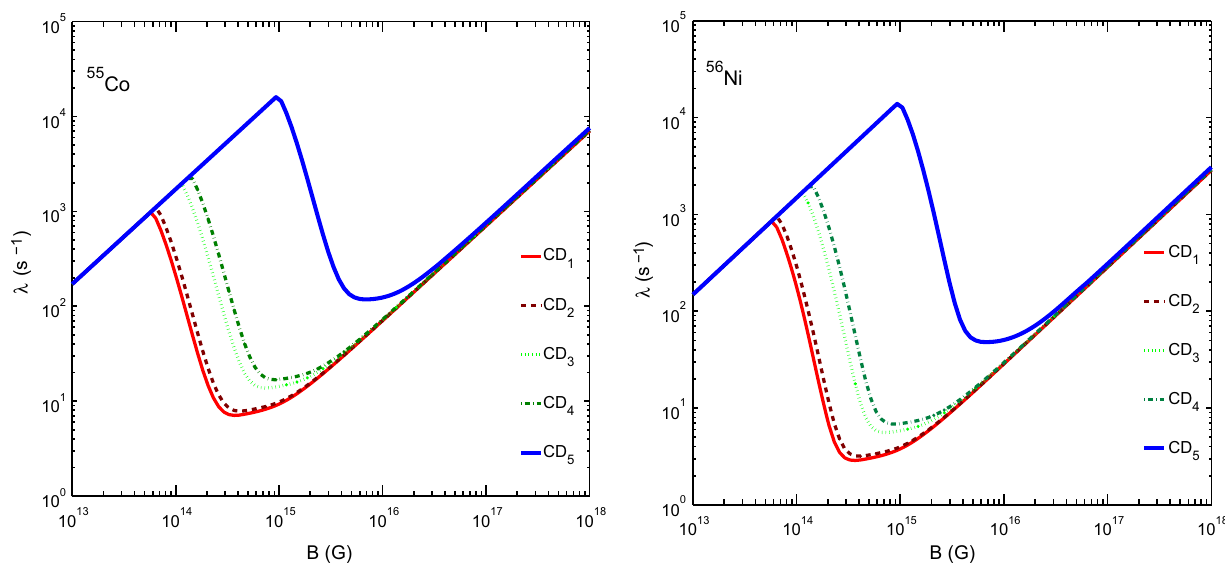
Fig. 2 The EC rates for 55 Co and 56 Ni as a function of magnetic field strength B under the different conditions CD i , i = 1–5, corresponding to ρ 7 = 5 . 86 , Y e = 0 . 47 , T 9 = 3 . 40; ρ 7 = 6 . 63 , Y e = 0 . 46 , T 9 =